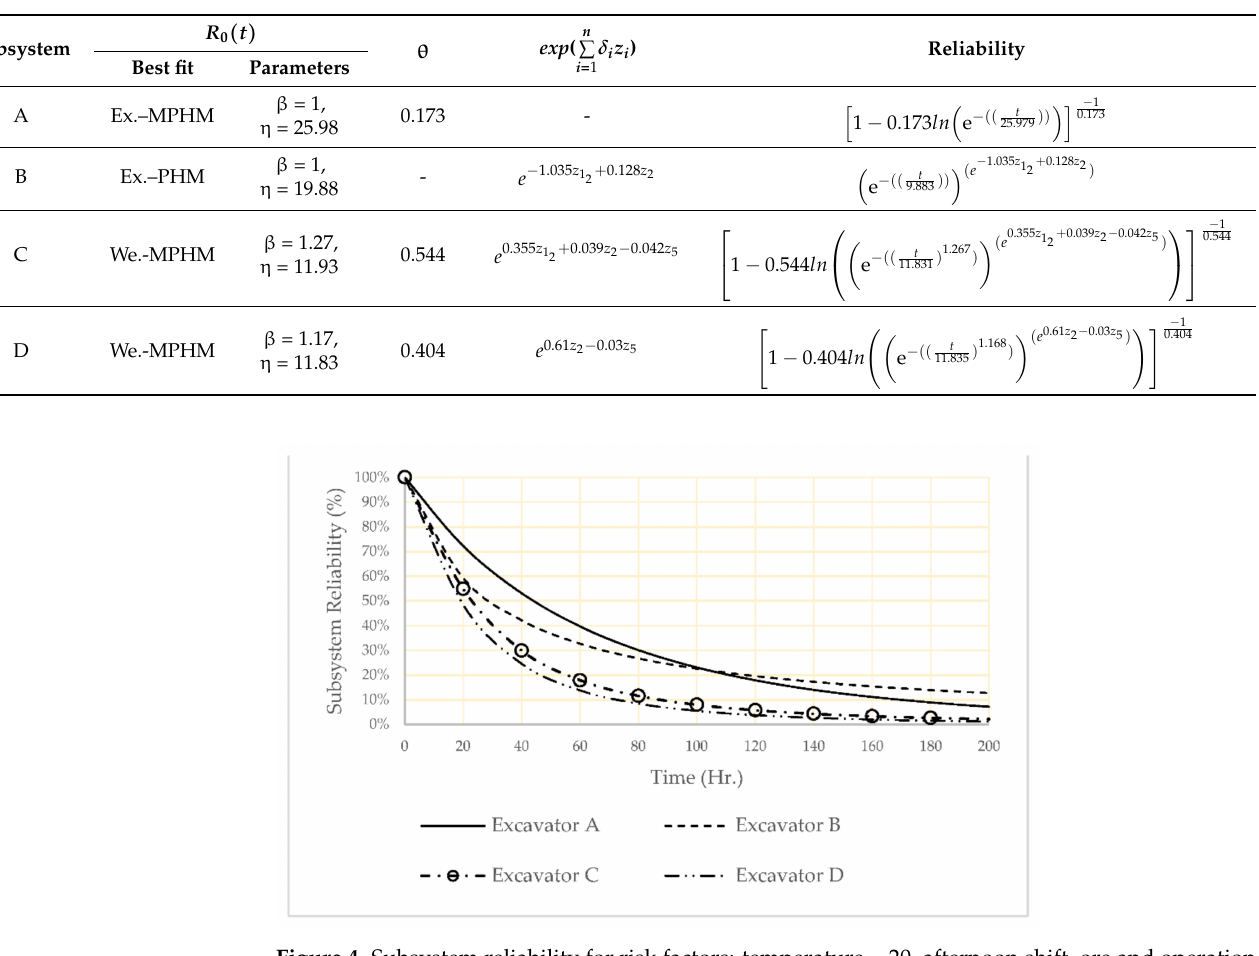
Figure 4. Subsystem reliability for risk factors: temperature = 20, afternoon shift, ore and operation team B.